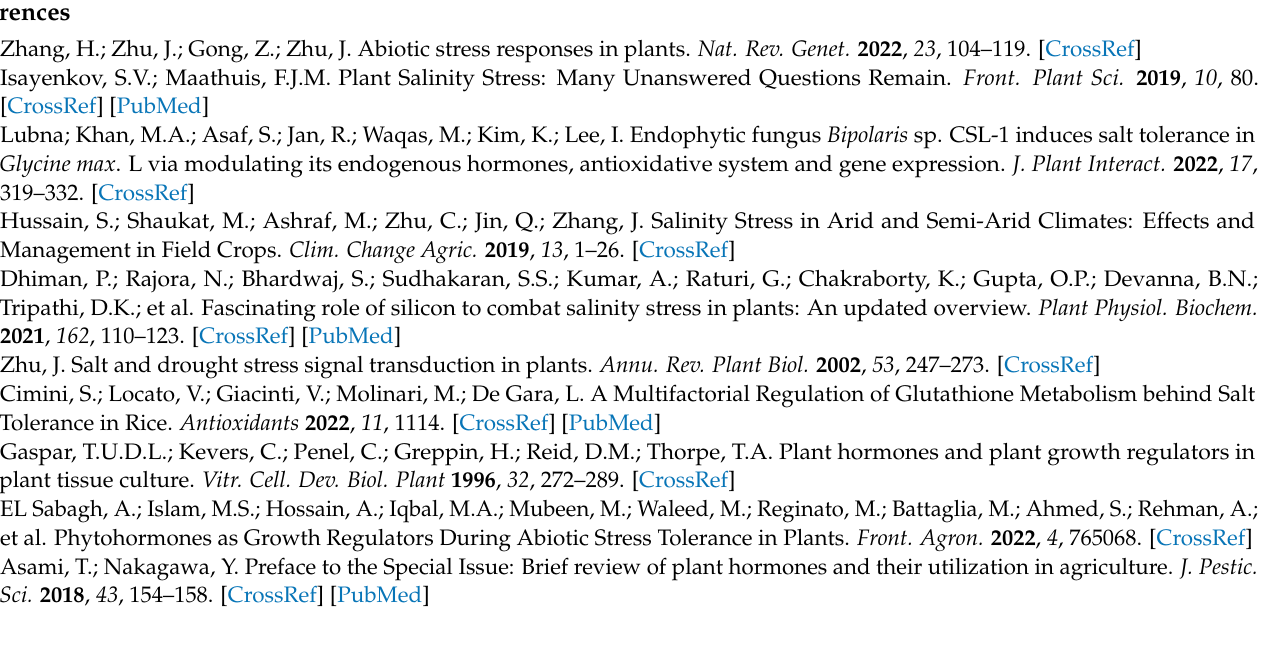
tary Table S2: Annotation of key candidate genes of plant hormone signal transduction pathway. Supplementary Figure S1: Statistics of differentially expressed genes. Supplementary Figure S2: Expression levels of genes co-annotated in plant hormone signal transduction pathway at 48 h and 168 h. Supplementary Figure S3: Phylogenetic tree analysis of T . ramosissima auxin and other species